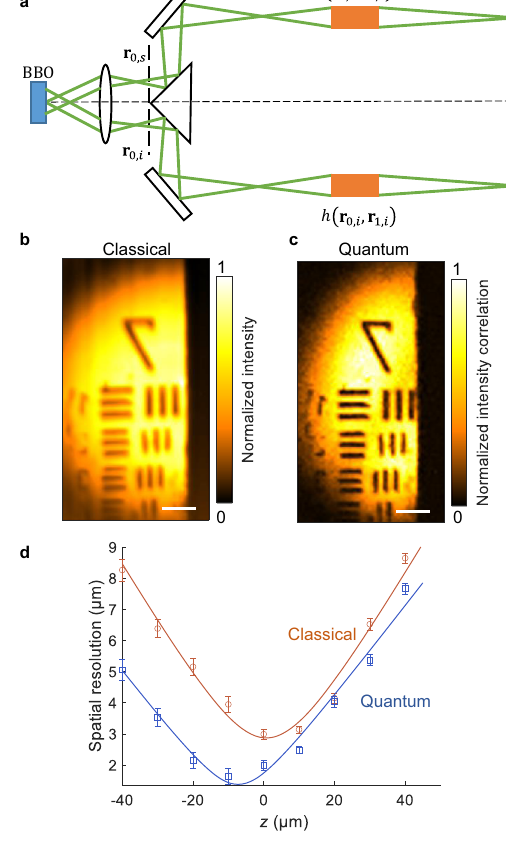
errorsofthemeans( n =14). e NormalizedlateralLSFsofclassicalimagingandQMC versus the lateral coordinate at different z